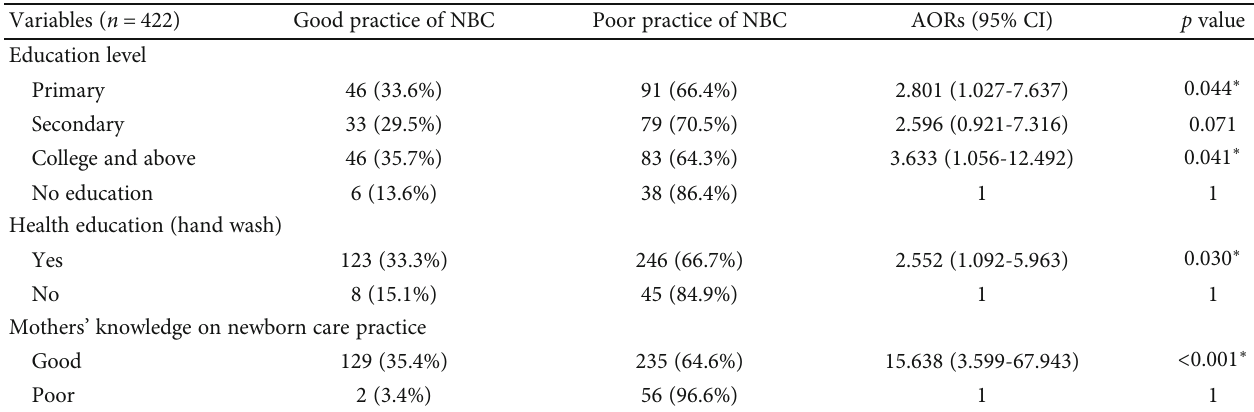
Table 5: Factors that are associated with newborn care practice of mothers with babies of one-month-old in Hossana town, southwest Ethiopia,